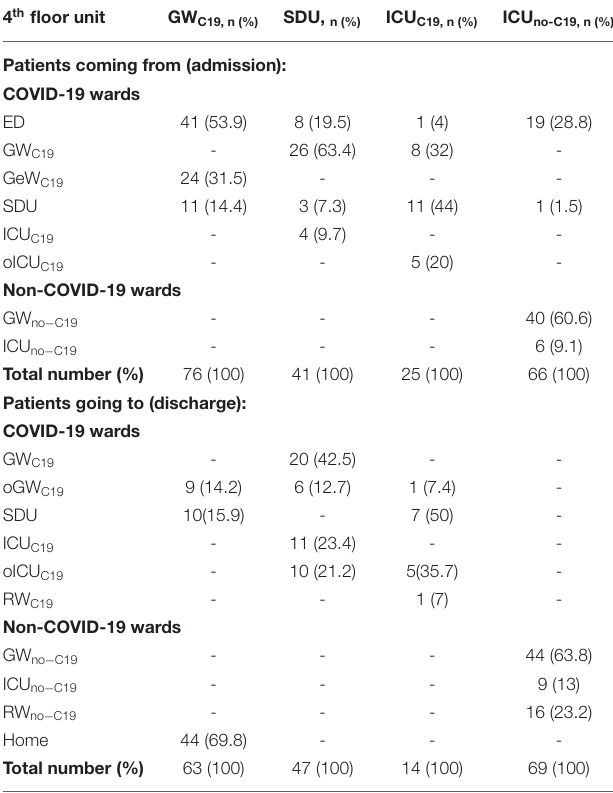
TABLE 1 | Clinical description of the patients admitted in the different units during the pandemic peak. GW C19